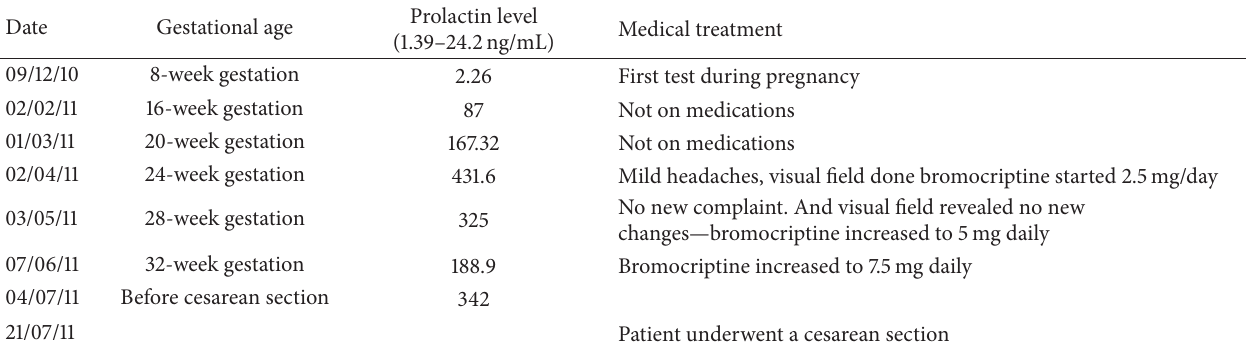
Figure 2: (a) Coronal T1-weighted MRI post-Gd-DTPA showing inhomogeneous enhanced sellar lesion, deviation of the pituitary stalk to the right side. This was taken 1.5 years after pituitary apoplexy in November 2009. Pituitary fossa is filled by CSF (empty sella). (b) Coronal T2-weighted MRI showing a hyperintense lesion within the pituitary floor and deviation of the pituitary stalk to the right side. This was taken 5 weeks after delivery in August 2011 showing the pituitary fossa filled with CSF (empty sella). Similar findings as those before pregnancy. Table 1: Prolactin levels throughout the